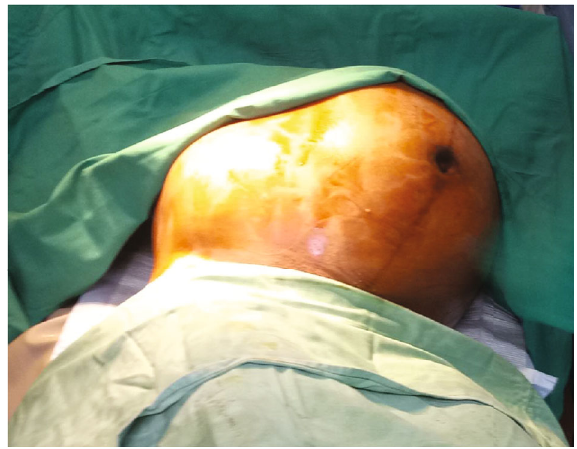
Figure 1: Outline of the uterus and the uterine fi broid before